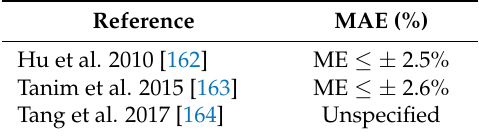
Table 15. MAE/ME of the LO-based SOC estimation